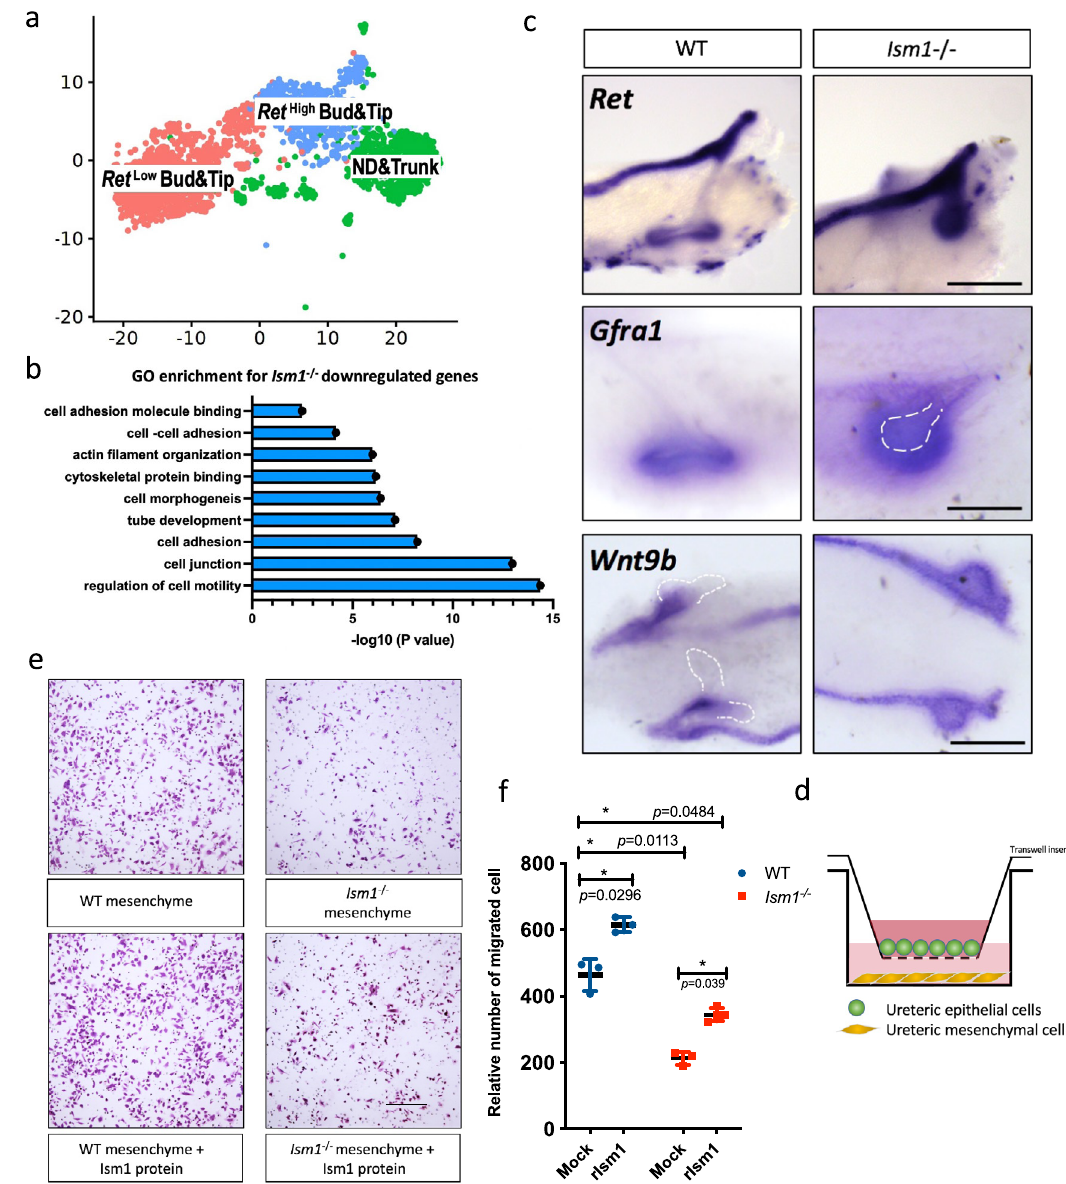
Fig.3|DifferenceinUElineagebetweenwild-typeand Ism1 − / − miceduringearly kidneydevelopment.a UMAPplotsof differentcelltypesinUElineagefromboth WT and Ism1 − / − mice. b GO enrichment of downregulated DEGs in Ret High Bud&Tip sub-cluster in Ism1 − / − kidney rudiment, as compared with WT. See